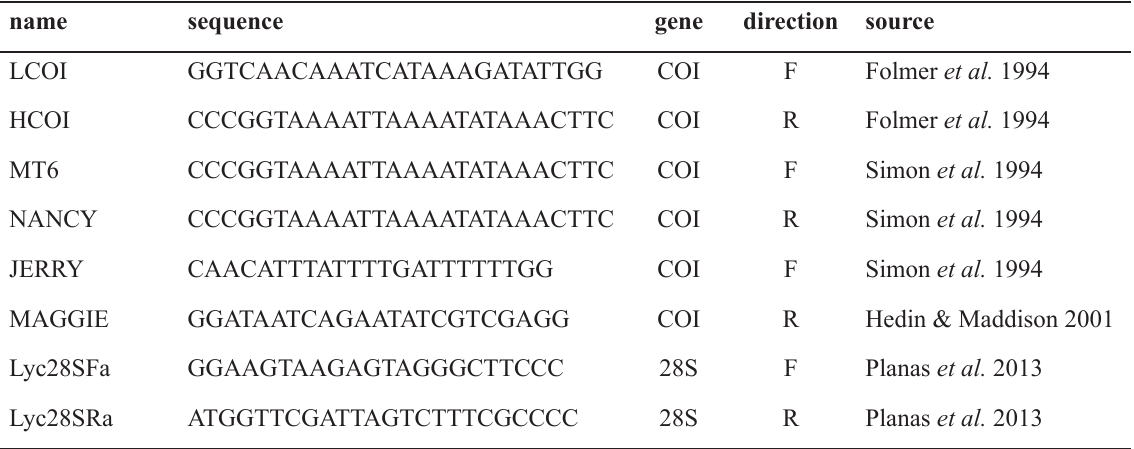
Table 3. Primers used in molecular phylogeny.